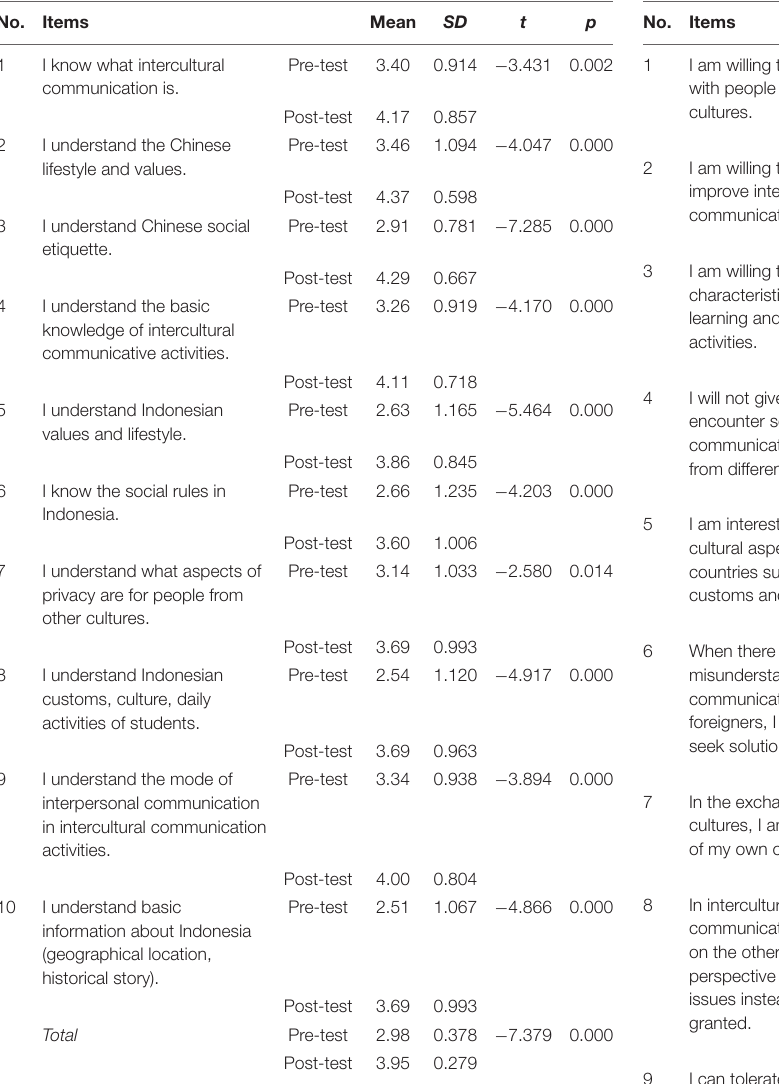
TABLE 1 | Knowledge dimension of ICC. TABLE 2 | Attitude dimension of